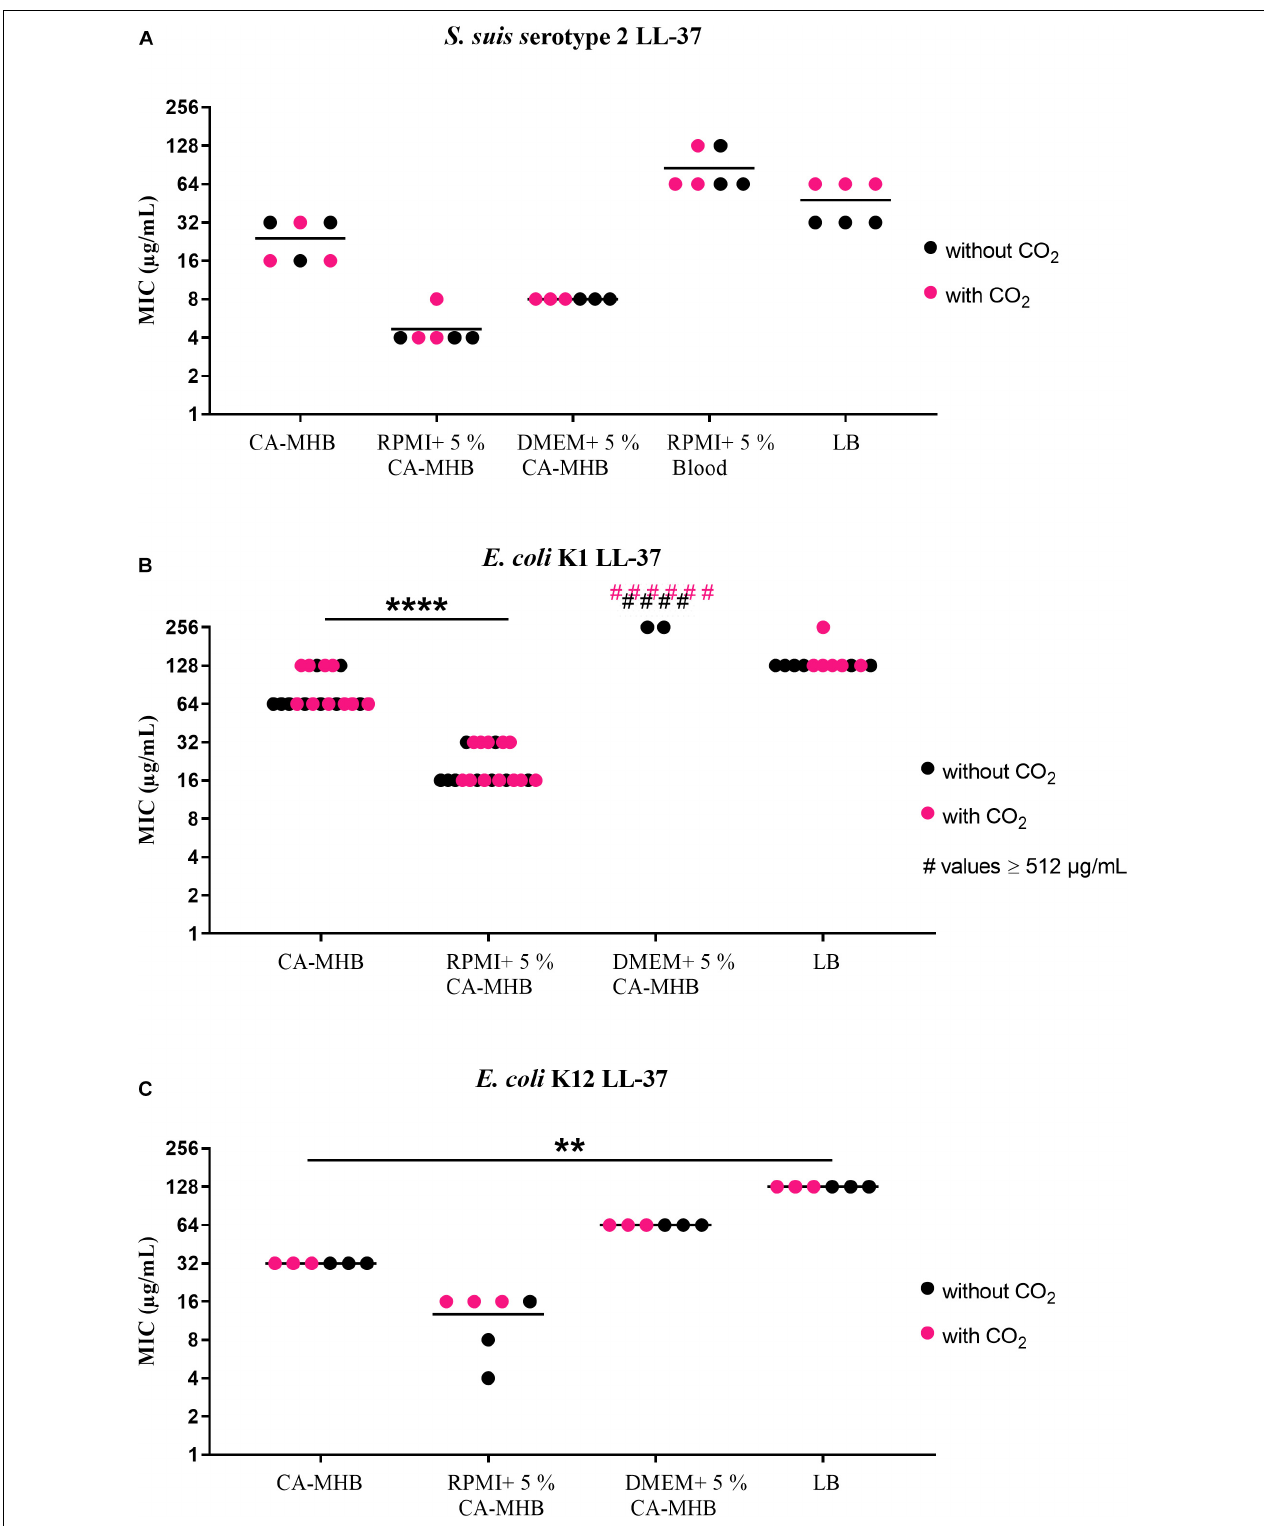
FIGURE 1 | MIC testing with LL-37 in accordance with CLSI recommendations by broth microdilution in different media (data shown are values from three independent experiments). (A) S. suis serotype 2, (B) E. coli K1, and (C) E. coli K12 against LL-37. Statistics: Kruskal–Wallis test with subsequent Dunn’s comparisons test ∗∗ p < 0.0021, ∗∗∗∗ p < 0.0001.